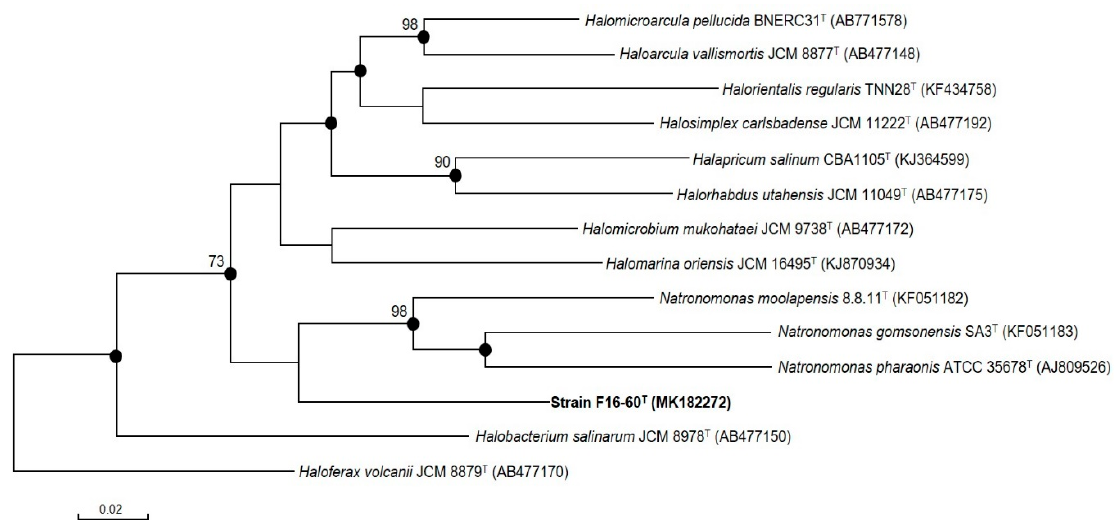
Figure 2. Phylogenetic reconstruction based on the comparison of the rpoB’ gene of strain F16-60 T and related members of the order Halobacteriales based on the maximum-likelihood algorithm. Filled circles indicate branches that were also supported by the neighbour-joining algorithm. Bootstrap values higher than 70% are indicated at branch-points. Sequence accession numbers are shown in parentheses. Bar: 0.02 substitutions per nucleotide position. The species Haloferax volcanii JCM 8879 T was used as an outgroup.